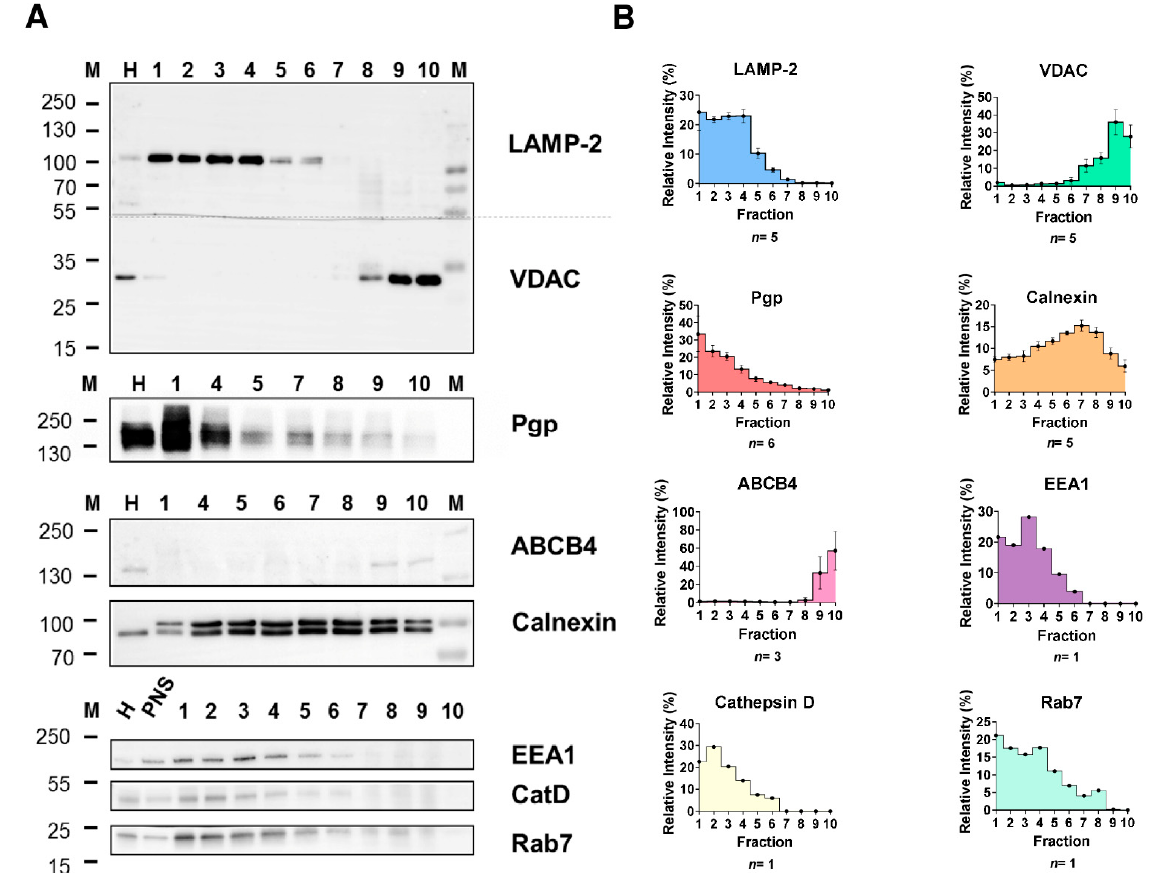
Figure 1. Biochemical characterization of rat liver subcellular fractions and Pgp localization in en- dolysosomal-enriched fractions. Rat liver subcellular fractionation was performed by low speed centrifugation and subsequent density gradient ultracentrifugation. Recovery and purity of the cell organelles from collected gradient fractions 1–10 (top to bottom) were analyzed by separation of equal protein amounts (5 µg) of each fraction and whole-cell homogenate (H) and post-nuclear su- pernatant (PNS) by SDS-PAGE and immunoblotting. Homogenate and PNS data were similar; thus, PNS is shown here for only some proteins. Endolysosomes were detected using the LAMP-2 and Rab7 marker proteins and the luminal lysosomal protease cathepsin D (CatD). EEA1 was used as a marker for early endosomes. The purity of the endolysosomal fractions was assessed by organelle markers for mitochondria (VDAC), canalicular plasma membrane (ABCB4), and ER (calnexin). ( A ) Representative Western blots showing the distribution of the different organelle protein markers and Pgp in the gradient fractions. Some fractions (mainly 2 and 3) contained low protein amounts and thus could not be characterized for the presence of all marker proteins for each individual gra- dient. Therefore, marker quantification in the gradient fractions was repeatedly performed for dif- ferent fractionations. ( B ) Quantification of the protein band intensities for the marker proteins in the different gradient fractions. Immunoblotting revealed recovery of endolysosomal vesicles from the top of the gradient (fractions 1–4) and co-fractionation of Pgp in the enriched endolysosomal frac- tions (1–4). Fraction 1 was essentially free of canalicular plasma membrane contamination and mi- tochondria but contains remnants of ER. Mitochondria localized in fractions 7–10 and were clearly separated from endolysosomal markers. The ER marker calnexin was present in each fraction, with the lowest amount in endolysosomal fraction 1. Values are expressed as the percentage of total marker protein levels detected in all fractions combined (set to 100%). Data are presented as means ± SEM; the number of quantified Western blots ( n ) is shown below the graphs.